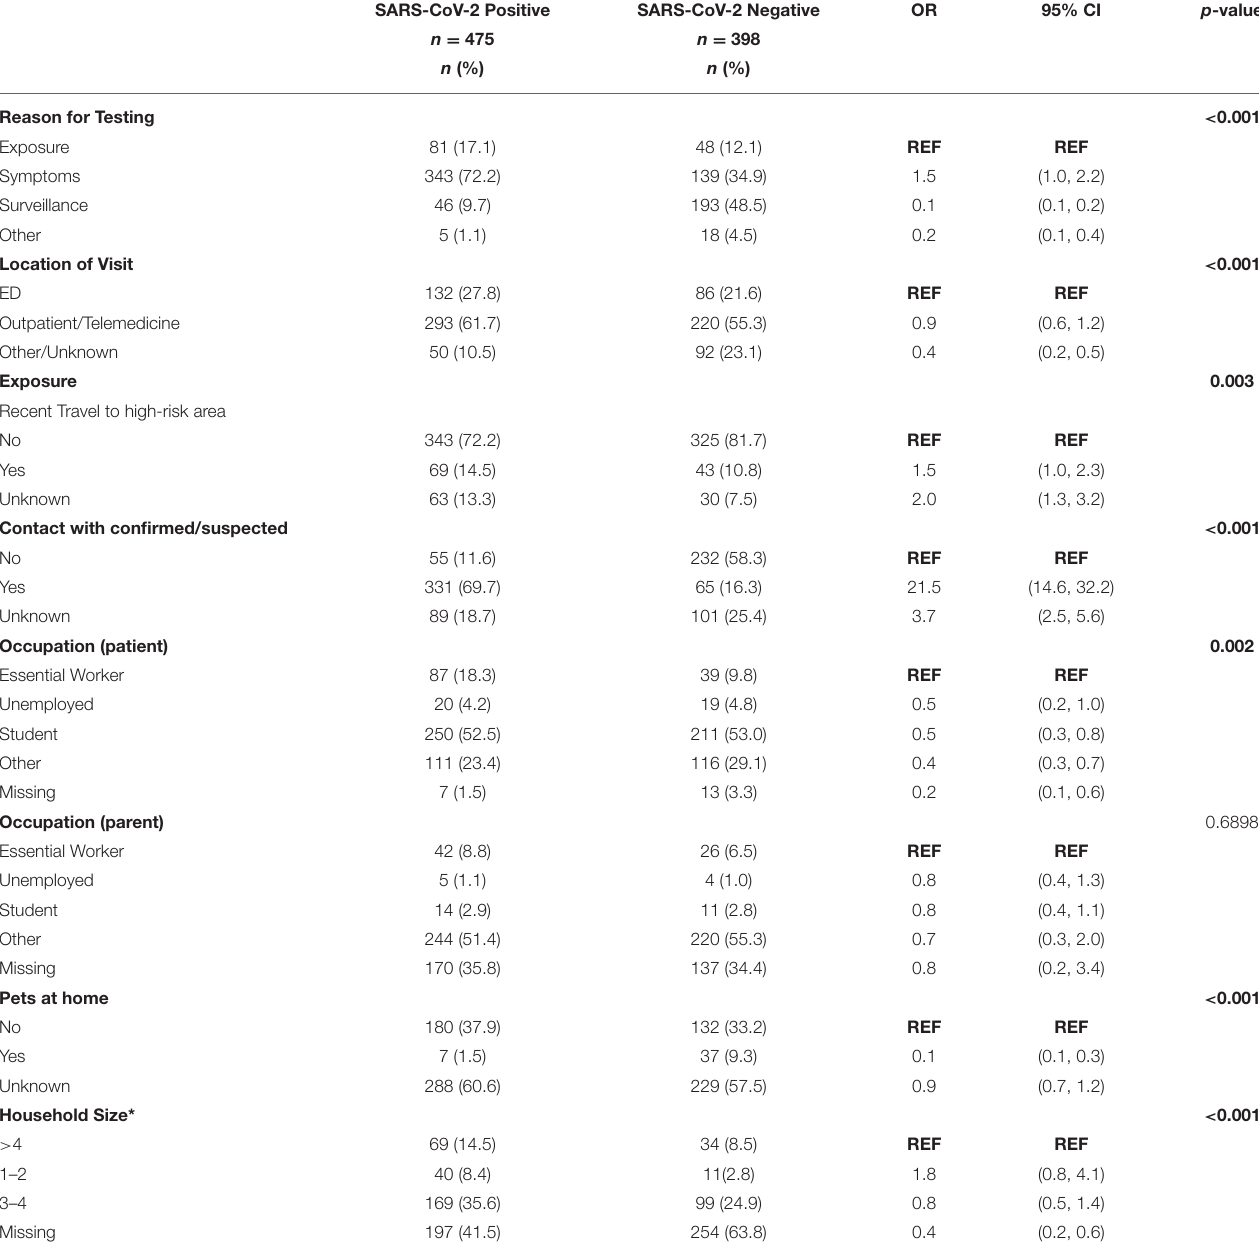
TABLE 2 | Risk factors for SARS-CoV-2 infection. SARS-CoV-2 Positive SARS-CoV-2 Negative OR 95% CI p